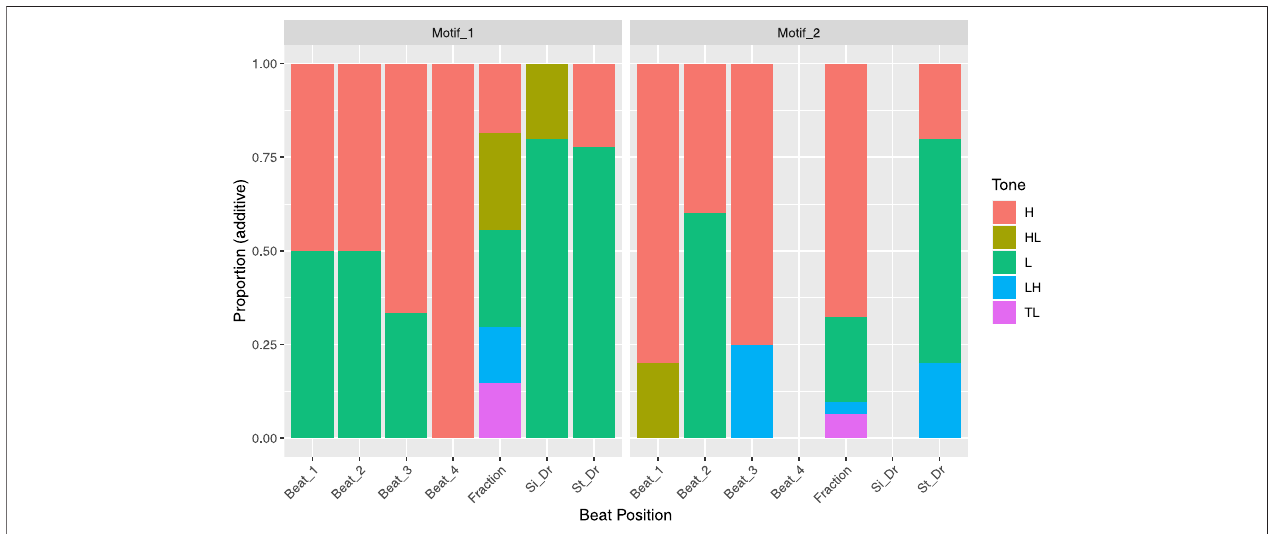
FIGURE 12 | Alignment of syllables by tone and motif in master drummer ’ s verses of Song 1 represented as proportions of occurrences.